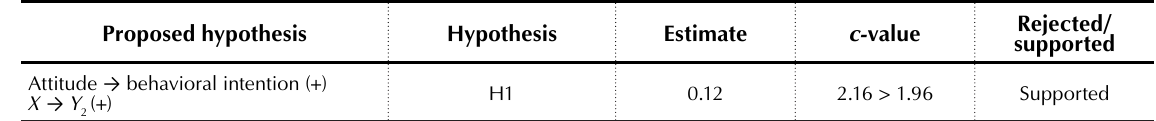
Table 1. Path coefficient for the attitude and the behavioral intention for tax compliance Proposed